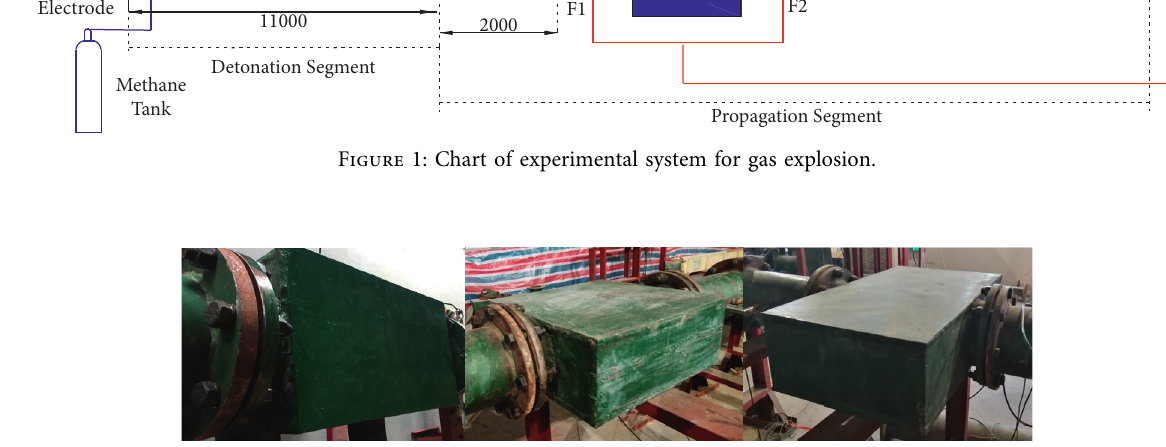
Figure 2: Experimental rectangular